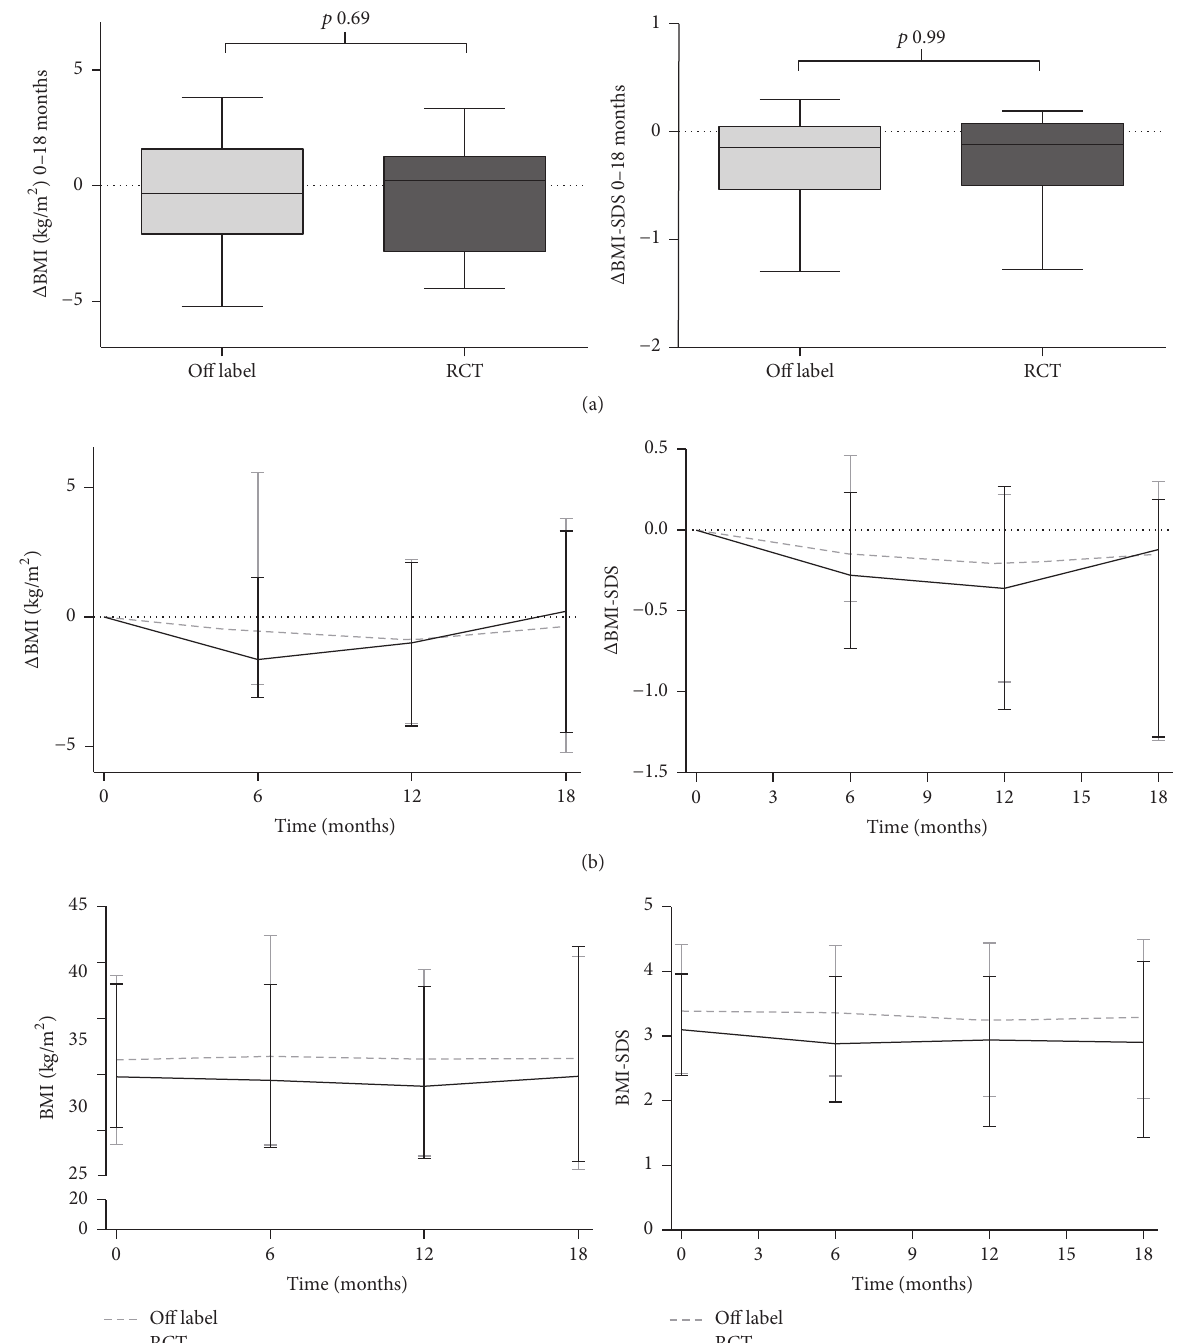
Figure 2: Change in BMI (left column) and BMI-SDS (right column) over 18 months of treatment. (a) Change between baseline and 𝑡 = 18 months. (b) Median Δ BMI (SDS) over time; (c) Median BMI ( SDS) over time. Graphs (b) and (c) represent median (min-max).